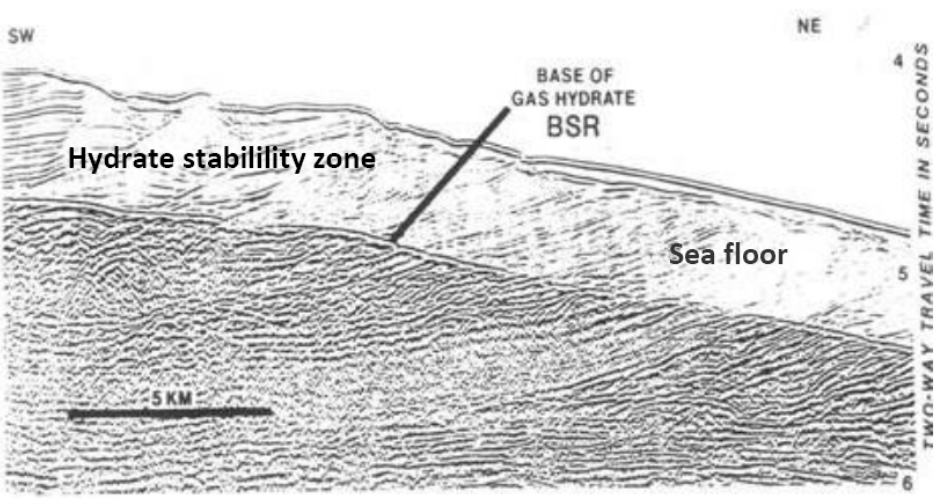
Figure 3. Schematic of Oceanic Seismic Section Showing a Strong Bottom Simulating Reflector (BSR) and Overlying Hydrate Stability Zone. (Modified after Kvenvolden